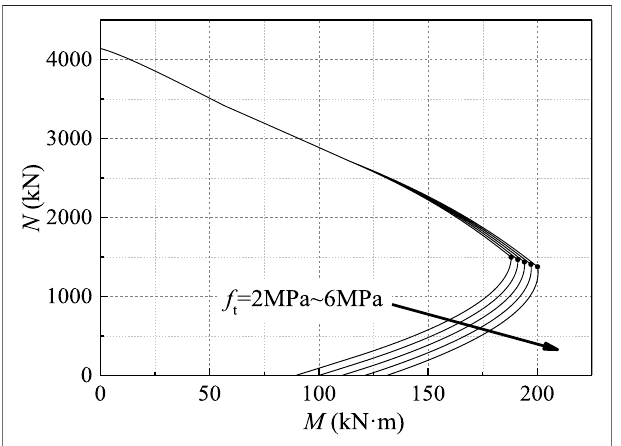
FIGURE 9 | N-M interaction curves with different ECC tensile strengths.